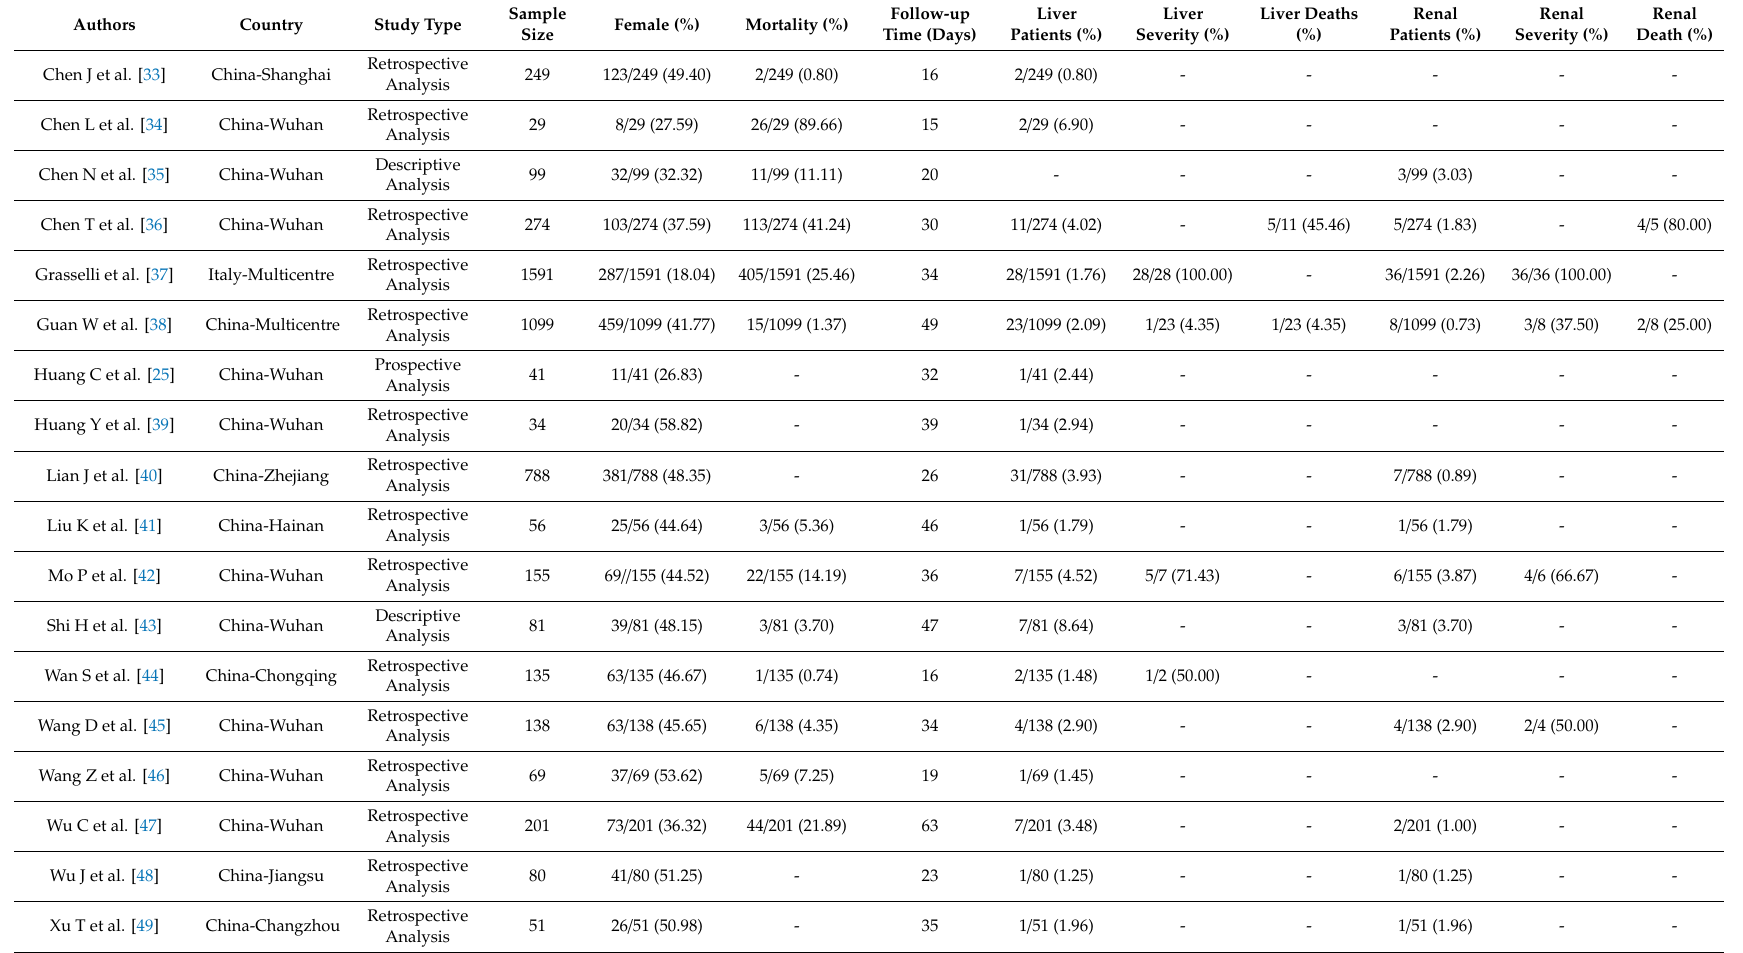
Table 1. Characteristics of the studies included. Severity is defined as extended hospital stay, need for ICU or mechanical ventilation. Mortality is defined as death associated with